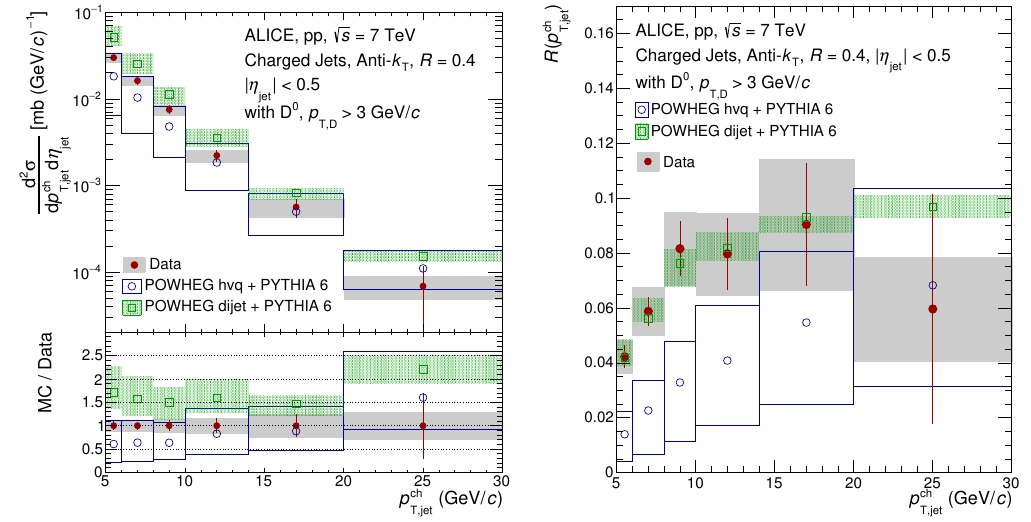
Figure 6 . p T -di(cid:11)erential cross section of charm jets tagged with D 0 mesons (left) and its ratio to the p inclusive jet cross section (right) in pp collisions at s = 7 TeV. The solid red circles show the data with their systematic uncertainties represented by the grey boxes. The measurements are compared with the POWHEG heavy-quark (open circles) and di-jet (open squares)